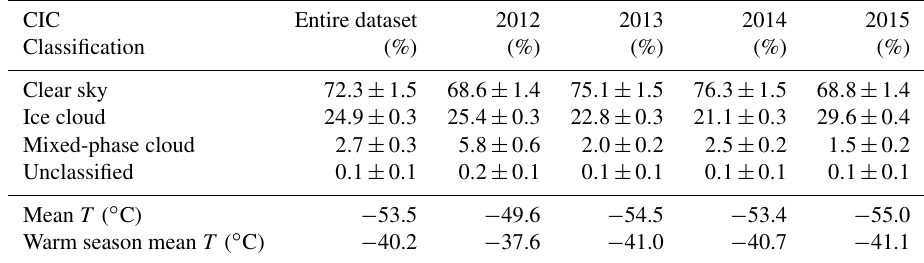
Table 4. CIC classification results for the whole REFIR-PAD spectra dataset (2012–2015) and for single years. The associated uncertainties are computed using Eq. (15). Mean air temperatures at surface level for the entire period and for each year are also reported. The last row refers to mean air temperatures at surface level computed for the months from November to March (warm season).